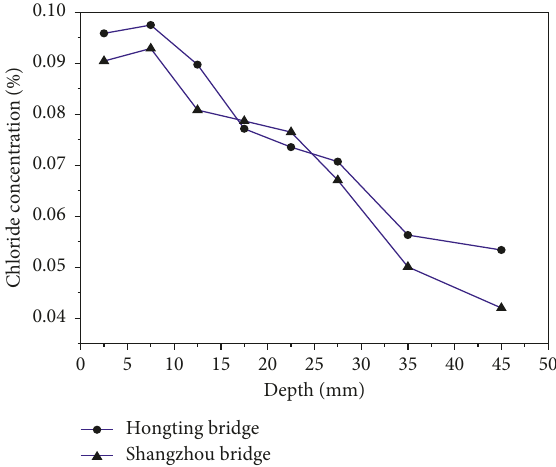
Figure 3: Chloride profile in the marine concrete